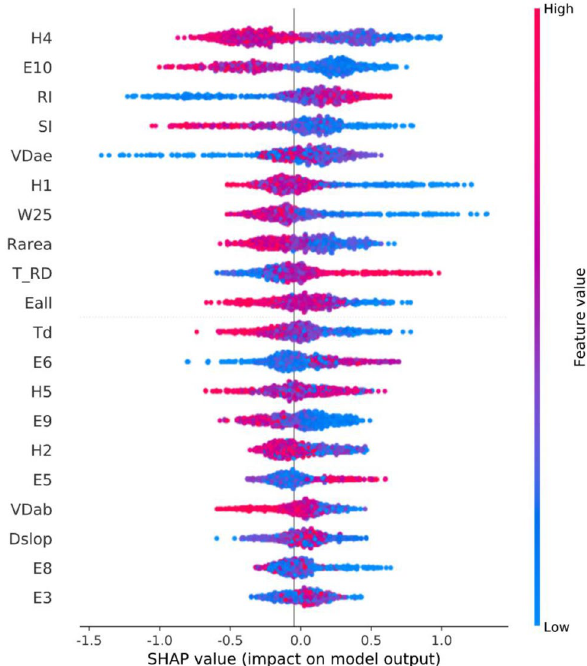
Figure 5. Feature importance analysis by SHAP